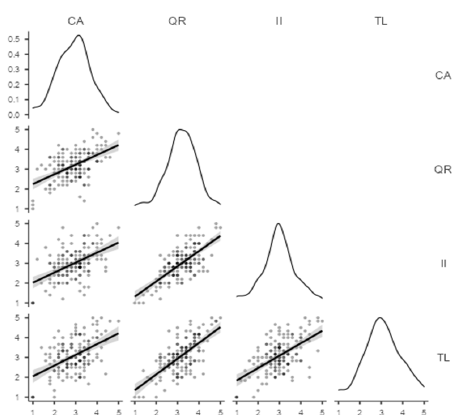
Fig. 2. Plot of the residuals ( Source: Jamovi output